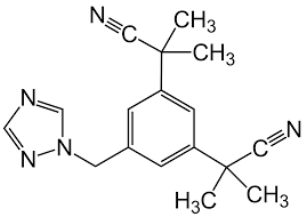
Figure 3. Chemical structure of anastrazole. Formula: C 17 H 19 N 5.